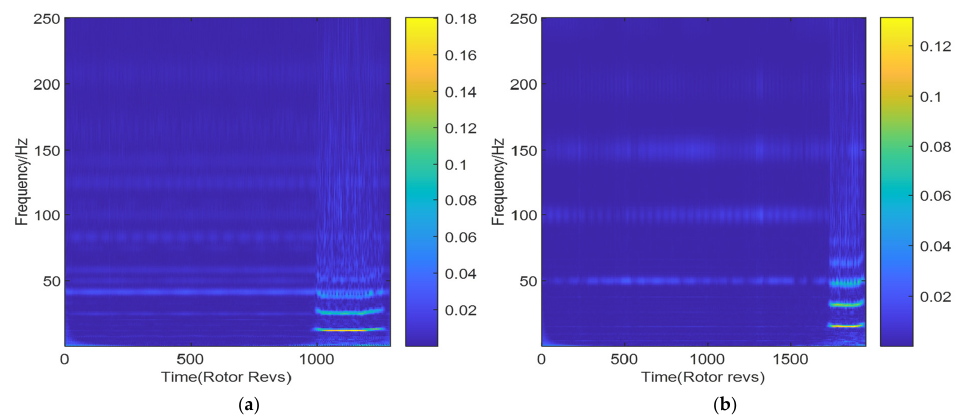
Figure 3. Time-frequency diagram of the first-order spatial mode: ( a ) Diagram at 2500 rpm; ( b ) Diagram at 3000 rpm.